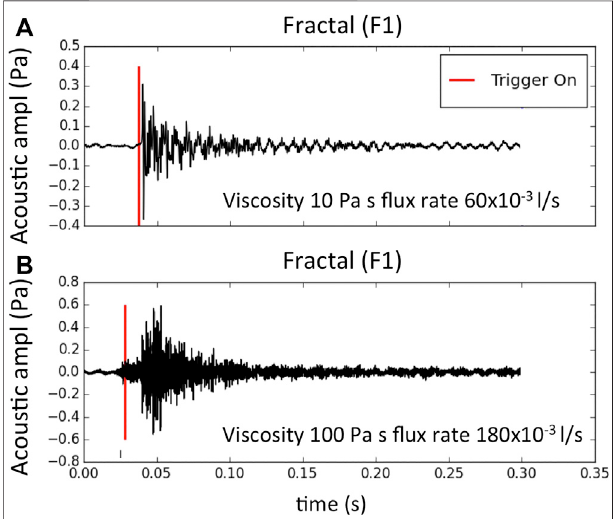
FIGURE 5 | Examples of automatic picking of two acoustic events by STA/LTA algorithm. Both events were generated with a F1 fractal roughness conduit but with different viscosity and fl ux rate conditions. For the event in plot (A) viscosity (cid:2) 10 Pa s and fl ux rate (cid:2) 60 × 10 − 3 l/s; for event in plot (B) viscosity (cid:2) 100 Pa s and fl ux rate (cid:2) 180 × 10 − 3